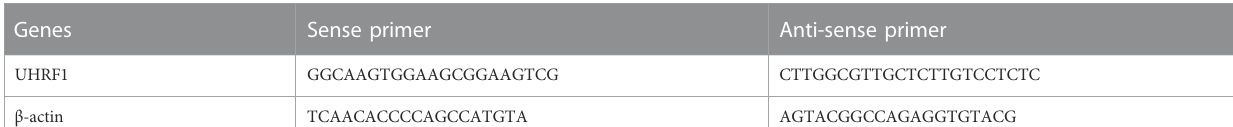
TABLE 2 Primers for real-time PCR (5 9 to 3 9 ).